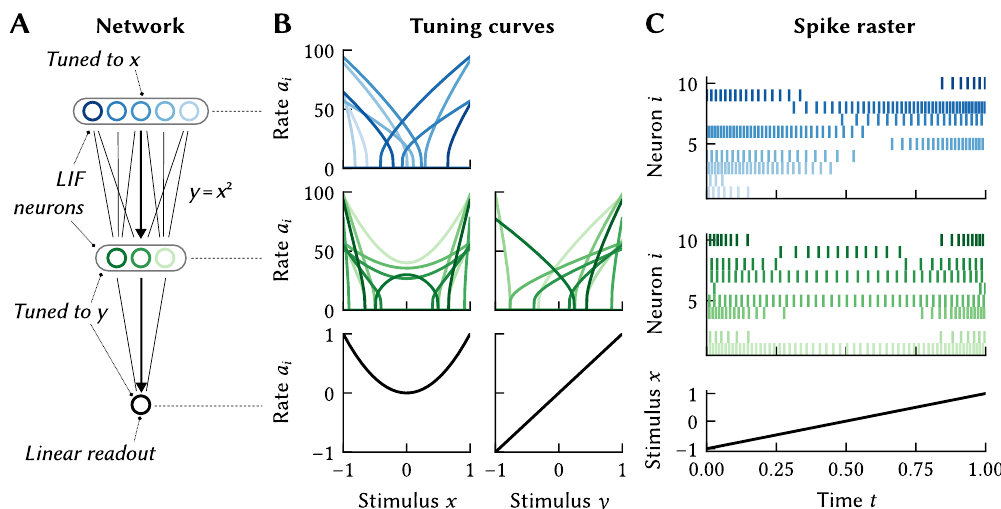
Figure 4. Transforming signals. ( A ) Two LIF neuron populations (blue, green) are tuned to variables x , y . The first population projects onto to the second; we impose the relationship y = f ( x ) = x 2 when solving for weights. The black “neuron” is a linear readout with G [ J ] = J . ( B ) Tuning curves of the neurons depicted in (A) . Left column depicts the tuning curves over x , right column the tuning curves over y . The tuning of the first (blue) population is undefined with respect to y . When controlling the stimulus variable x the network implicitly computes f ( x ) = x 2 . ( C ) Spike raster of the two LIF populations when varying the stimulus x over time; although we solve for weights using a rate approximation G [ J ] , the resulting network is compatible with spiking